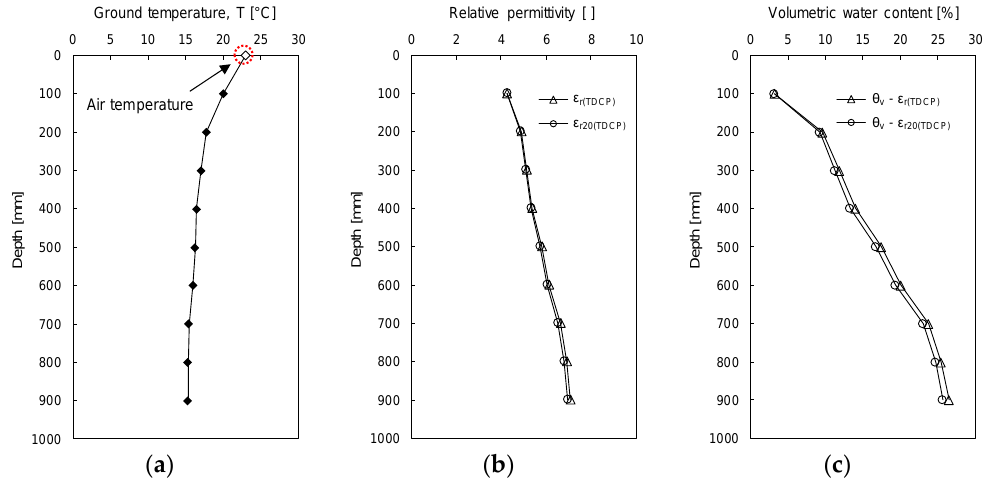
Figure 14. Ground temperature, relative permittivity, and volumetric water content evaluated in the field test: ( a ) Ground temperature; ( b ) Relative permittivity; ( c ) Volumetric water content.